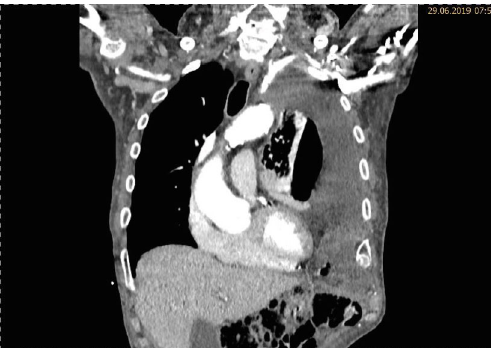
Figure 2: Axial thoracoabdominal CT scan with left-sided